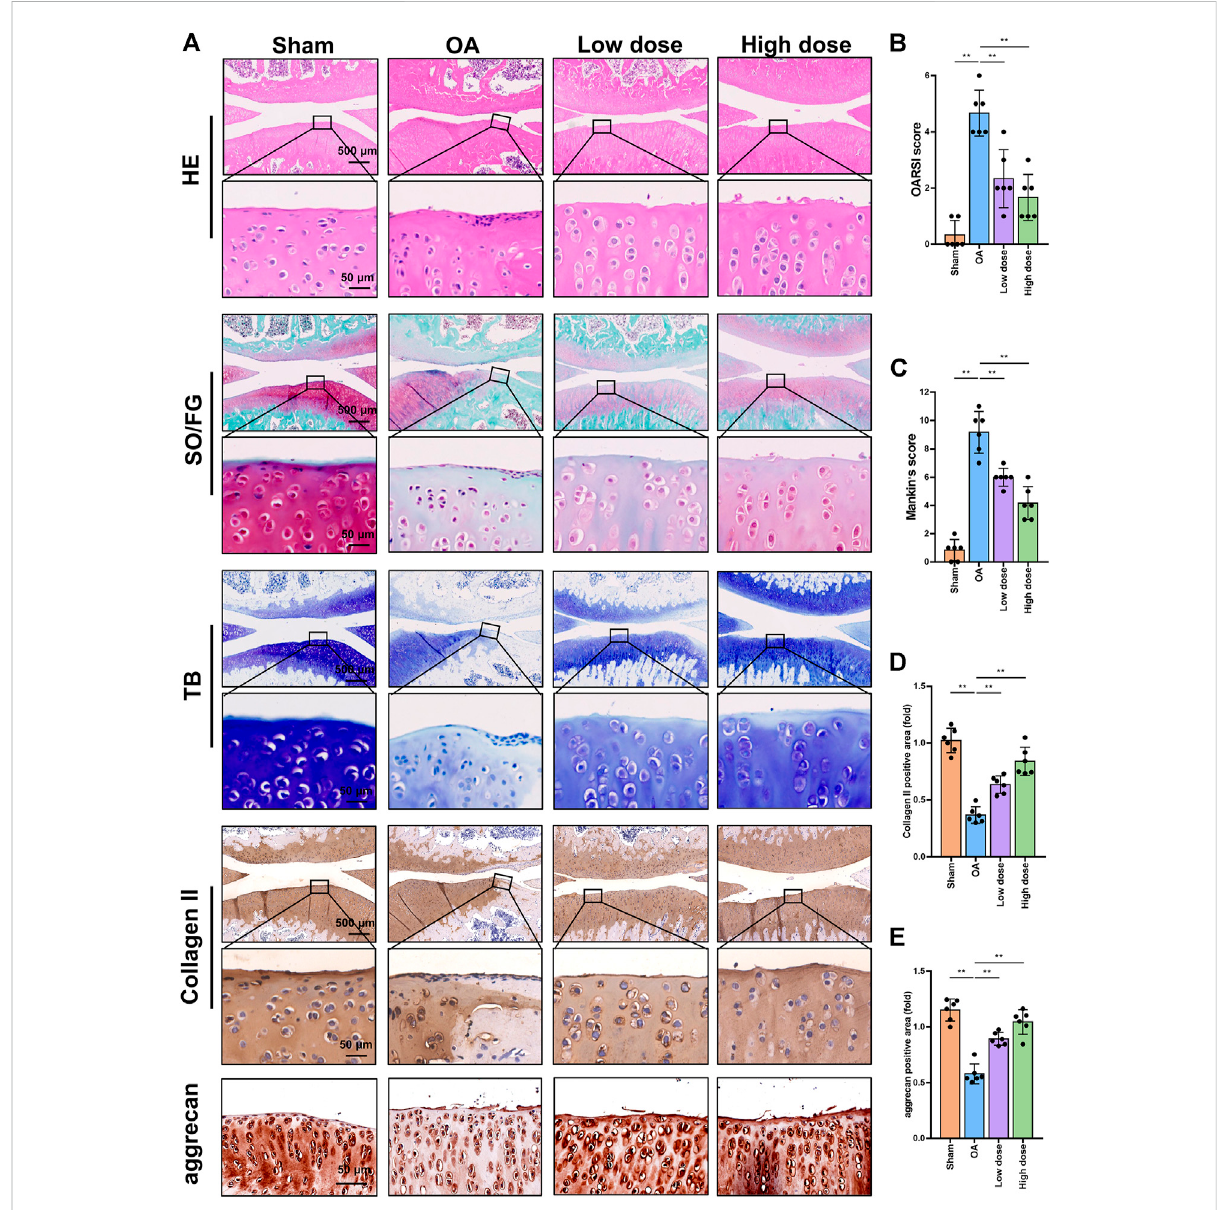
Histopathology and immunohistochemistry analysis of rat knee joints. (A) Representative images of HE, SO/FG, TB, collagen type II and aggrecanstaining.Imagesarepresentedatlowmagni fi cation(×4magni fi cation,scalebar,500 μ m)andhighmagni fi cation(×40magni fi